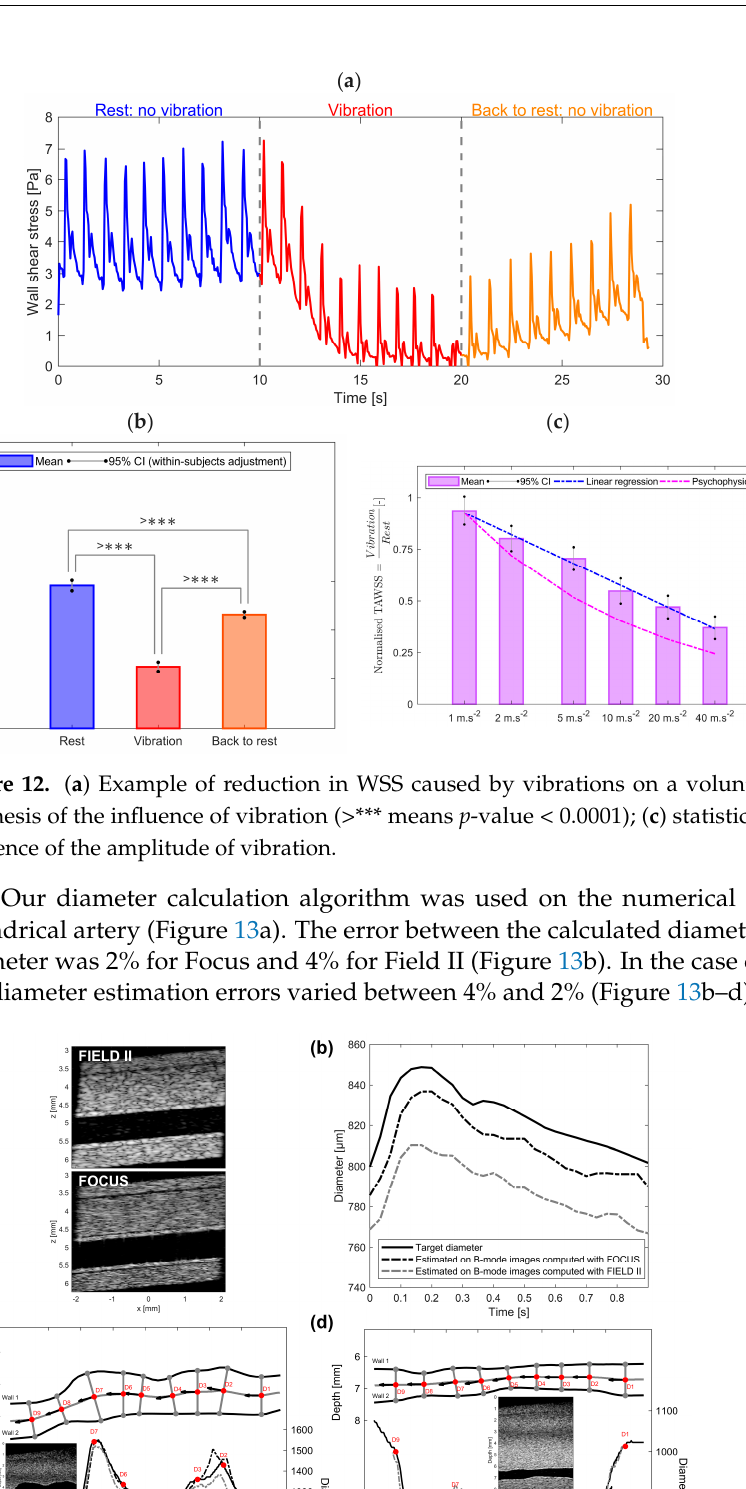
Figure 14. Polar representation of the time-averaged WSS computed from the full FSI, rigid wall, and Womersley models for nine Womersley cutting paths defined from slice 2.